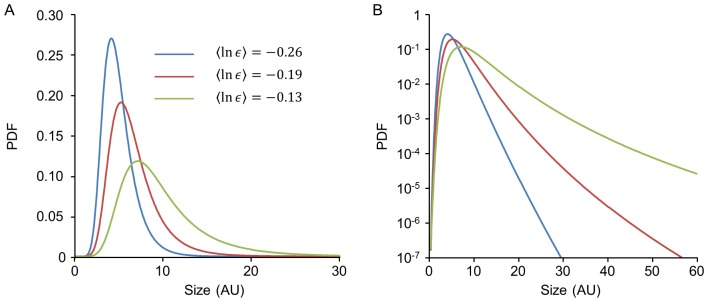
Limiting distributions of the Kesten process in the stable regime.(A) Simulations for three different distributions of ε corresponding to different values of 〈ln ε〉 with the distribution of η held fixed. Note that as 〈ln ε〉 approaches 0 the limiting distribution approaches the instability boundary and broadens. (B) Same distributions as in A plotted on a semi-logarithmic scale.